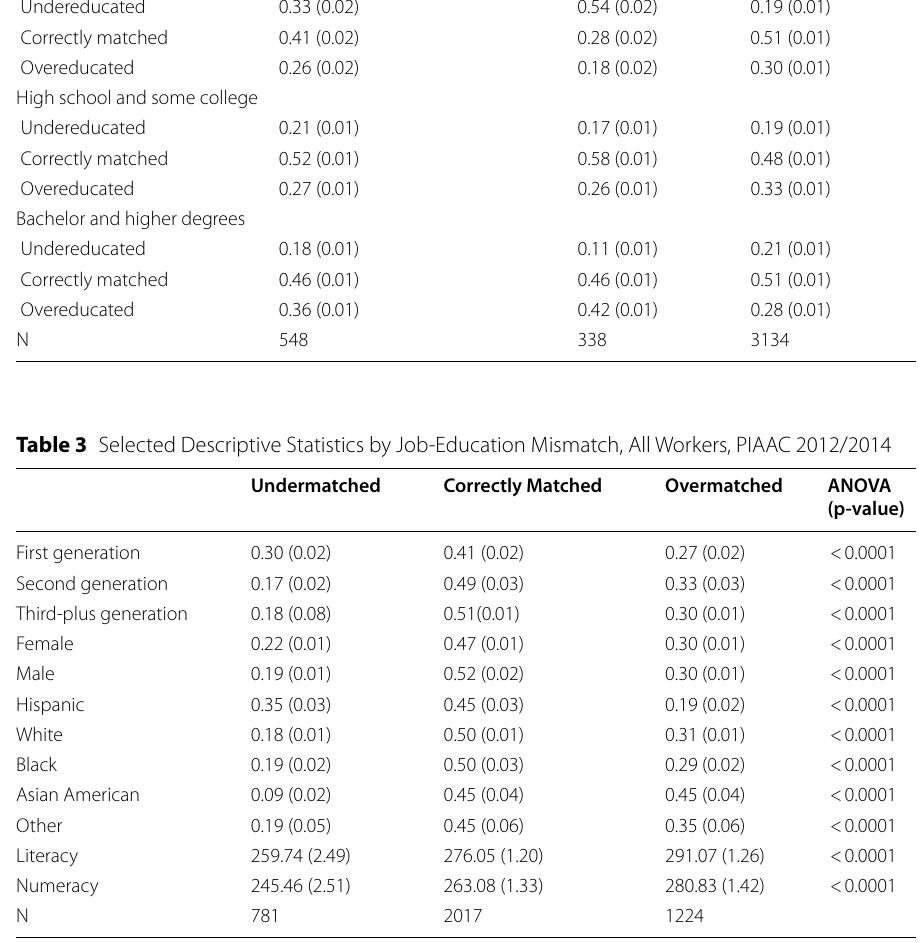
Numbers in the rows do not add up to 100% because of rounding. In the last column, we report p-values from ANOVA test with Bonferroni correction for the difference in means between undermatched, correctly matched, and overmatched workers. For all variables, statistically significant differences were found pairwise, i.e., between undermatched and correctly matched, undermatched and overmatched, and correctly matched and